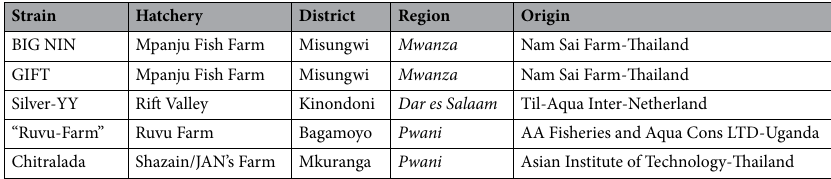
Table 1. Sampling locations in Tanzania and country of origin of Nile tilapia strains used in the